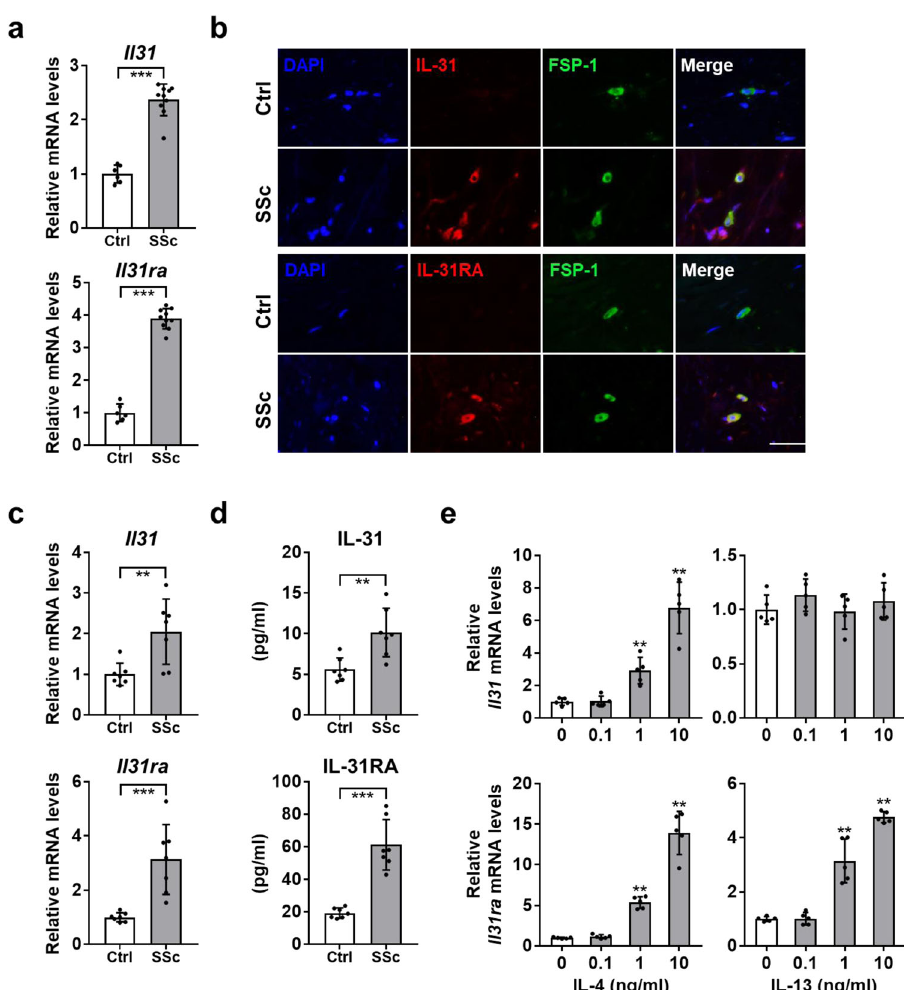
Fig. 2 IL-31 and IL-31RA were up-regulated in skin and DFs of SSc patients. a Relative mRNA expression levels of Il31 and Il31ra were analyzed by real- time PCR in the skin of SSc patients ( n = 10) and healthy controls ( n = 6). Exact p values = 0.0002 ( Il31 ); 0.0002 ( Il31ra ). Relative fold differences = 2.37 ( Il31 ); 3.89 ( Il31ra ). b Representative double-immuno fl uorescence images for IL-31 (top, red), IL-31RA (bottom, red), FSP-1 (green), and nuclei (DAPI, blue) in the skin of SSc patients and healthy controls (scale bar = 20 µ m). The results shown are representative of three independent experiments with similar results. c , d . Relative mRNA levels ( c ) and protein levels ( d ) of IL-31 and IL-31RA in DFs from SSc patients and healthy controls ( n = 7, respectively) were assessed by real-time PCR and ELISA, respectively. Exact p values = 0.007 ( Il31 ); 0.0006 ( Il31ra ); 0.004 (IL-31); 0.0006 (IL-31RA). Relative fold differences = 2.05 ( Il31 ); 3.13 ( Il31ra ). e. Relative mRNA expression levels of Il31 and Il31ra were examined by real-time PCR in SSc DFs stimulated with IL-4 or IL-13 ( n = 5, respectively). Exact p values (IL-4 0.1 ng/ml vs. media, IL-4 1 ng/ml vs. media, IL-4 10 ng/ml vs. media, IL-13 0.1 ng/ml vs. media,